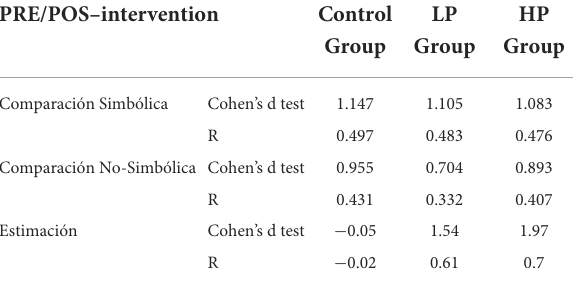
TABLE 6 Results of Cohen’s d test to calculate the effect size between pre- and post-intervention for the symbolic and non-symbolic comparison